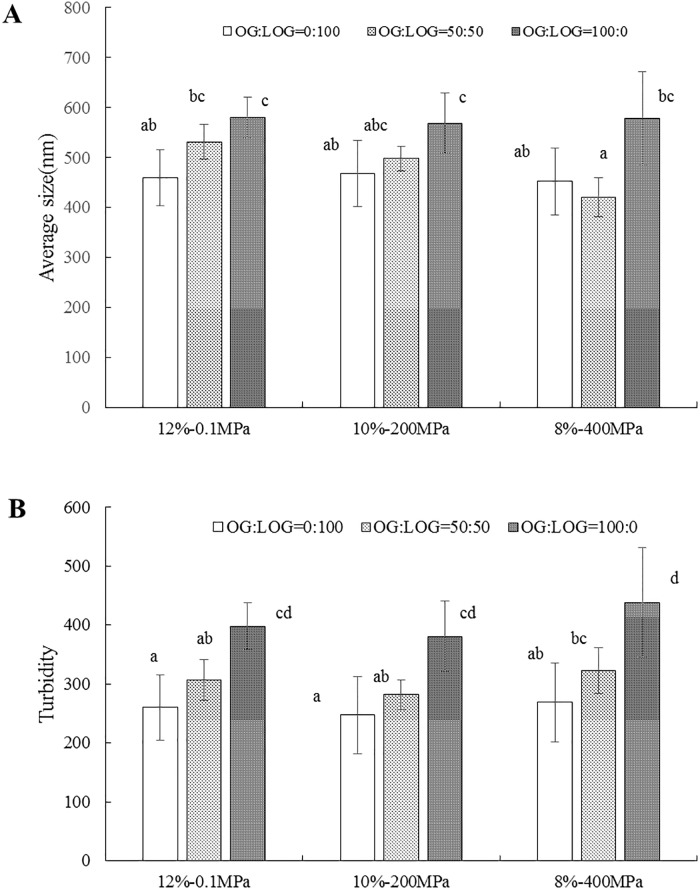
The effects of NaCl, urea and propylene glycol on hardness and springiness of the β-glucan mixed gels.(A) The hardness of the β-glucan mixed gels. (B) The springiness of the β-glucan mixed gels. (C) The G′ value of the β-glucan mixed gels. (D) The tan δ value of the β-glucan mixed gels. Different superscript letters indicate significant differences in the same graph (p < 0.05).